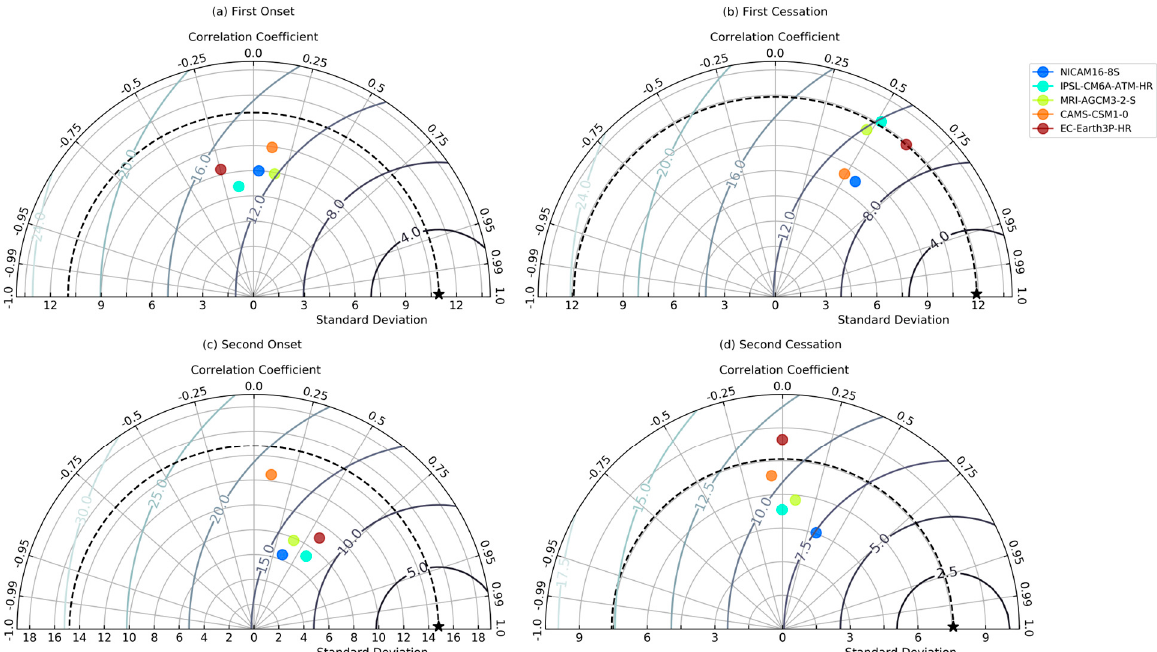
Figure 9. Statistical evaluation of models using Taylor diagram analysis to show the coefficient of correlation, standard deviation, and centred root mean square error of ( a ) first onset, ( b ) first cessation, ( c ) second onset, and ( d ) second cessation over region R2. Different colour dots represent different datasets as described in the legend. Five-pointed star represents the observational dataset.